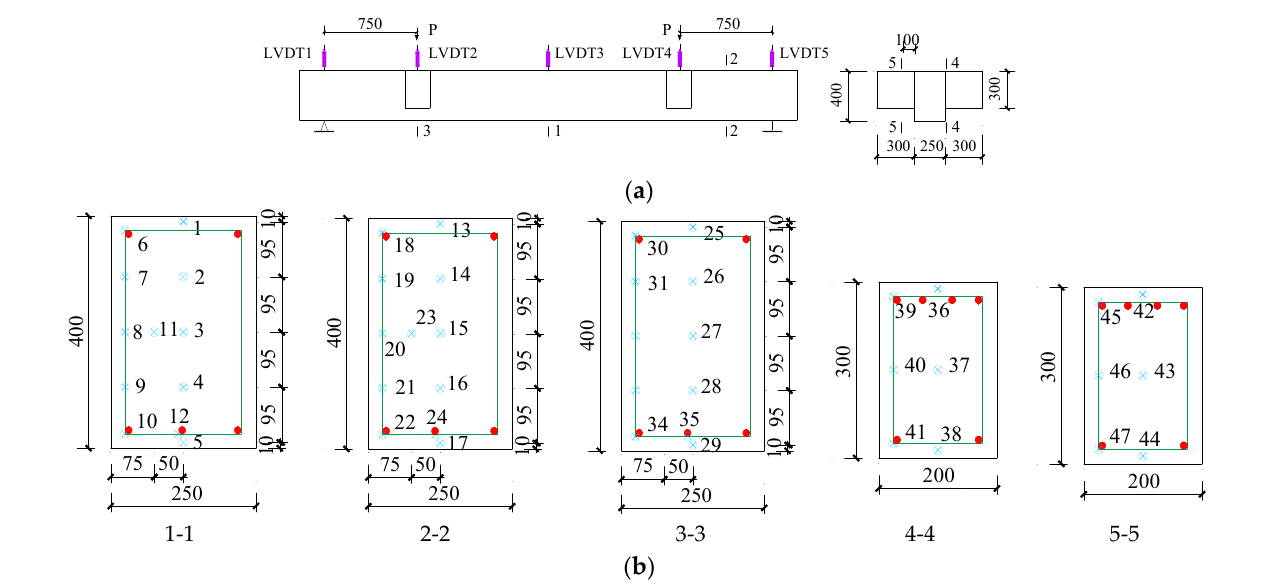
Figure 4. Locations of LVDTs and thermocouples (dimensions in mm). ( a ) LVDTs of the preloaded beam and ( b ) thermocouples.